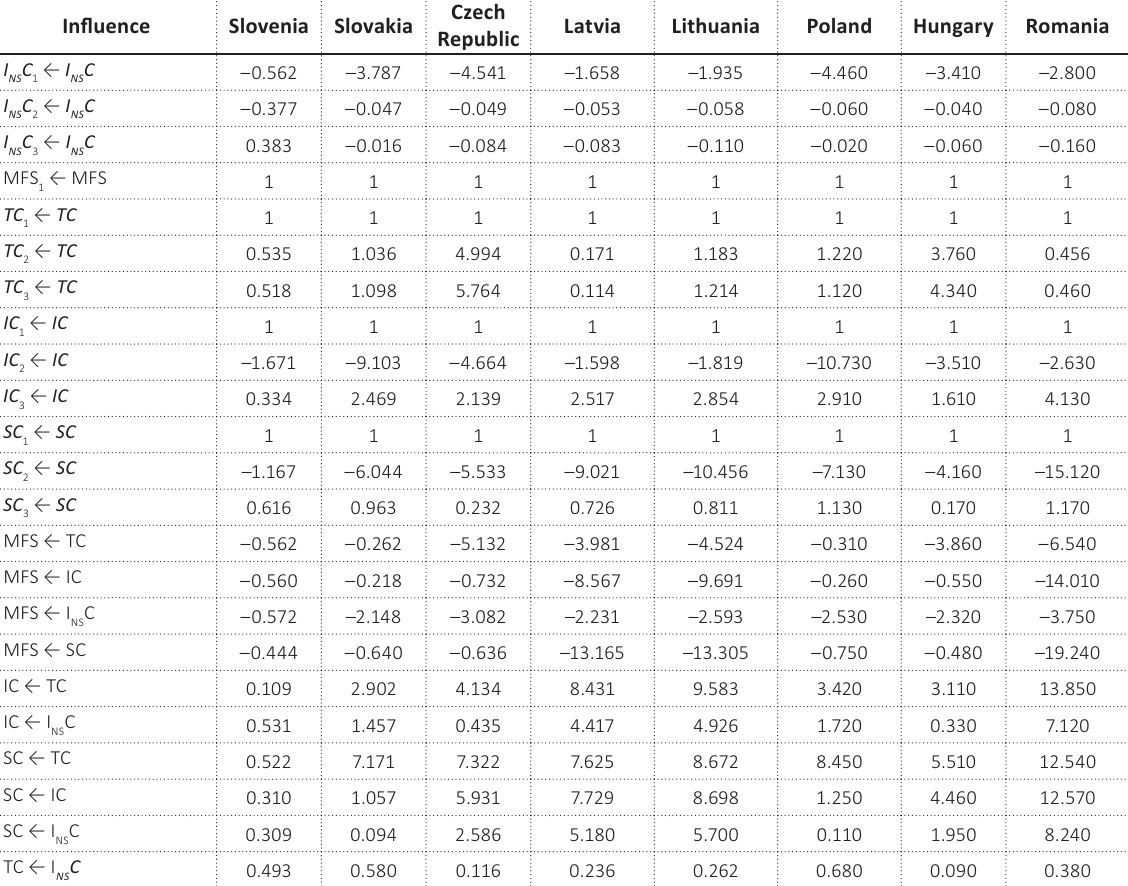
Table 3. Parameters of the model of influence of shadow economy relevant determinants on